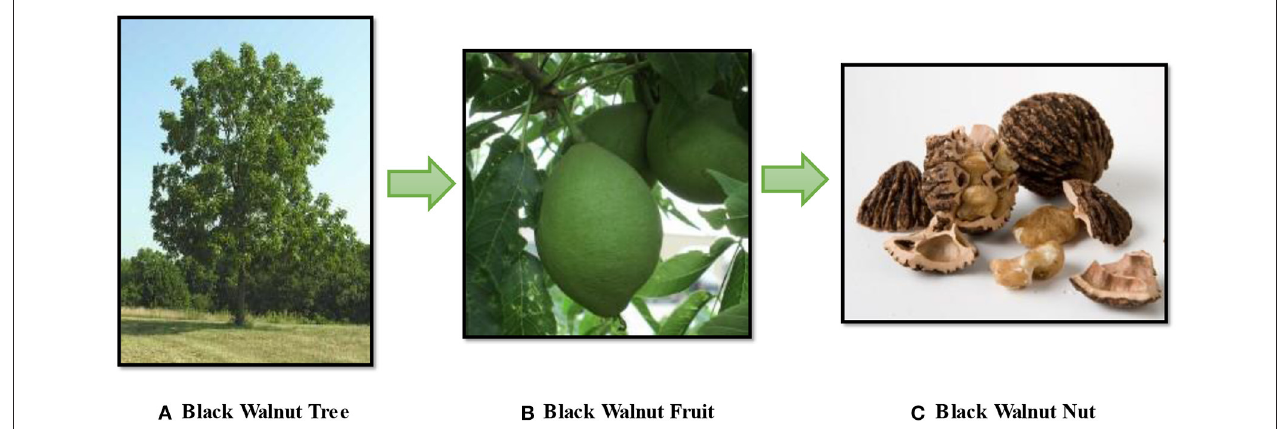
FIGURE 1 | Black Walnut (A) Tree, (B) Fruit, (C) Nut (Photo Courtesy: Hammons Products Company, Stockton, Missouri).